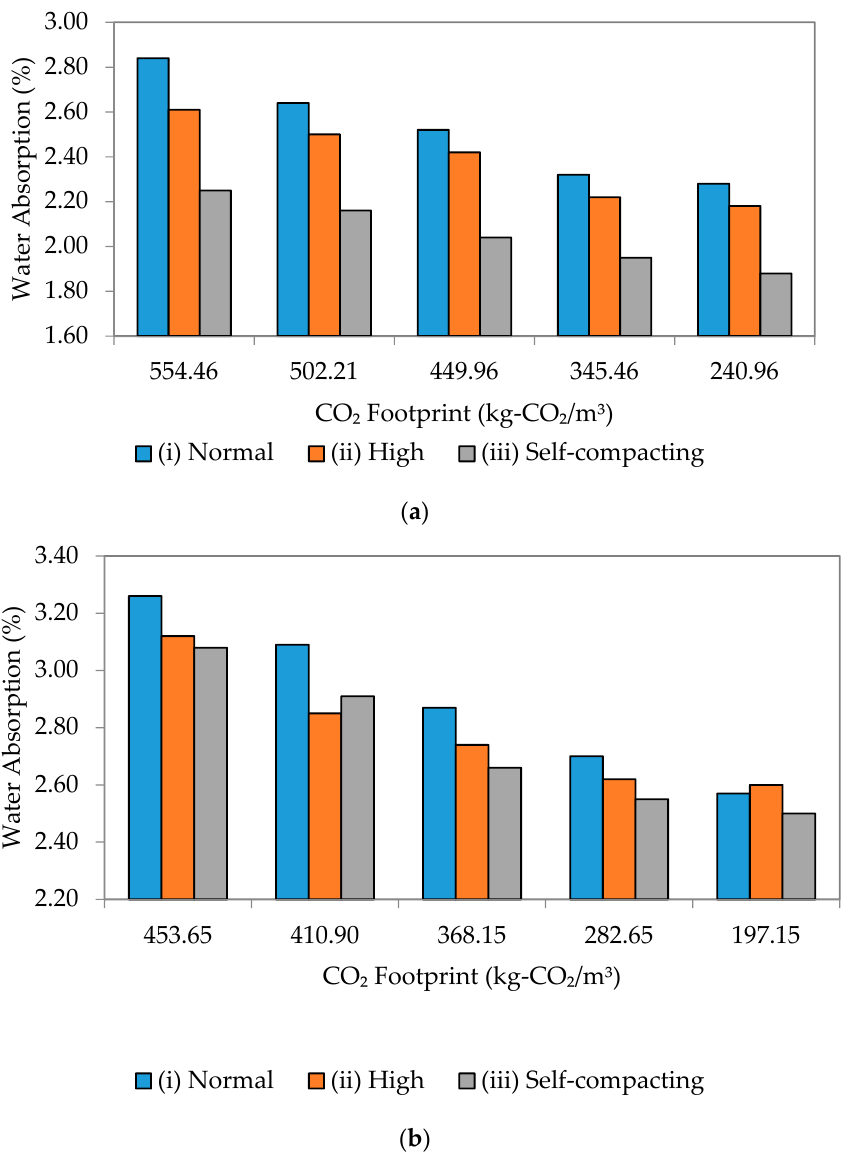
Figure 18. Water absorption to CO 2 footprint of different flowability. ( a ) w/b 0.35; ( b ) w/b 0.40.